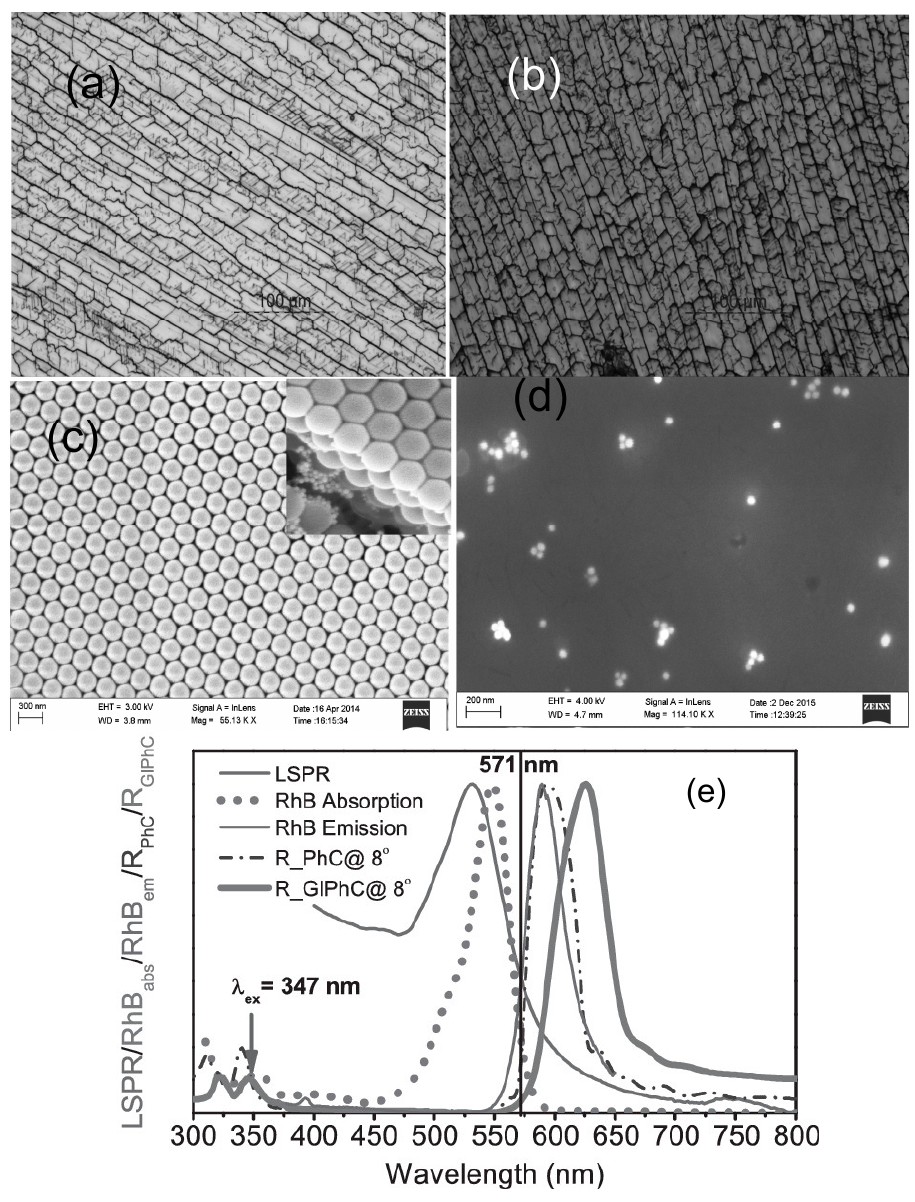
Figure 2. Optical microscope images of: ( a ) PCs; and ( b ) GIPC, grown from polystyrene colloids with average diameter of 277 nm. The scale bar is 100 μ m; ( c ) The FESEM image of PCs with the same colloidal diameter showing hexagonal periodic arrangement on the top surface. The scale bar is 300 nm. The inset shows the ordering in the different layers of the crystal, and the smaller particles inside the cracks are the gold nanoparticles infiltrated into the structure; ( d ) The FESEM image of AuNPs dispersed over a silicon substrate yields an average value of 40 nm for their diameter; ( e ) The normalized spectra of all features present in the sample, where the solid vertical line at 347 nm denotes the excitation wavelength and the vertical line at 571 nm marks the wavelength of maximum spectral overlap between the emission spectrum and the LSPR band of gold nanoparticles. Spectral bands (from left to right): first band is LSPR due to AuNPs, RhB in dot line is due to Rhodamine B absorption, then RhB line is due to RhB emission, R_PhC@8 in dot line is due to RhB in polystyrene PCs, and finally R_GIPhC@8 in thick solid gray line is due to RhB in polystyrene PCs infiltrated with AuNPs (adapted from [60]).